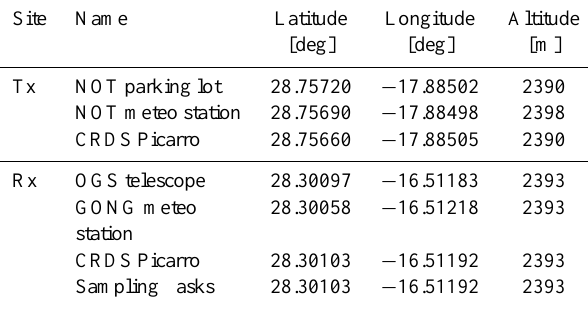
Table 1. GPS-derived positions of the telescopes/parking lot and the validation stations at the transmitter (Tx) and receiver (Rx) sites. The meteorological station near the OGS is named GONG (its customary local name) and the cavity ring-down spectrometer for in situ GHG measurements of the company Picarro is named CRDS. Table 3 provides more details on the data sets